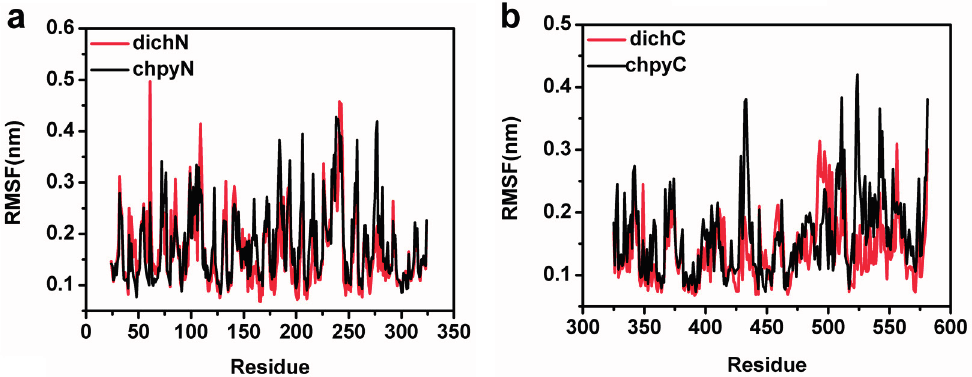
Figure 7. ( a ) RMSF plot during 100 ns MD (residues 24–324 ( β –propeller domain)). Color